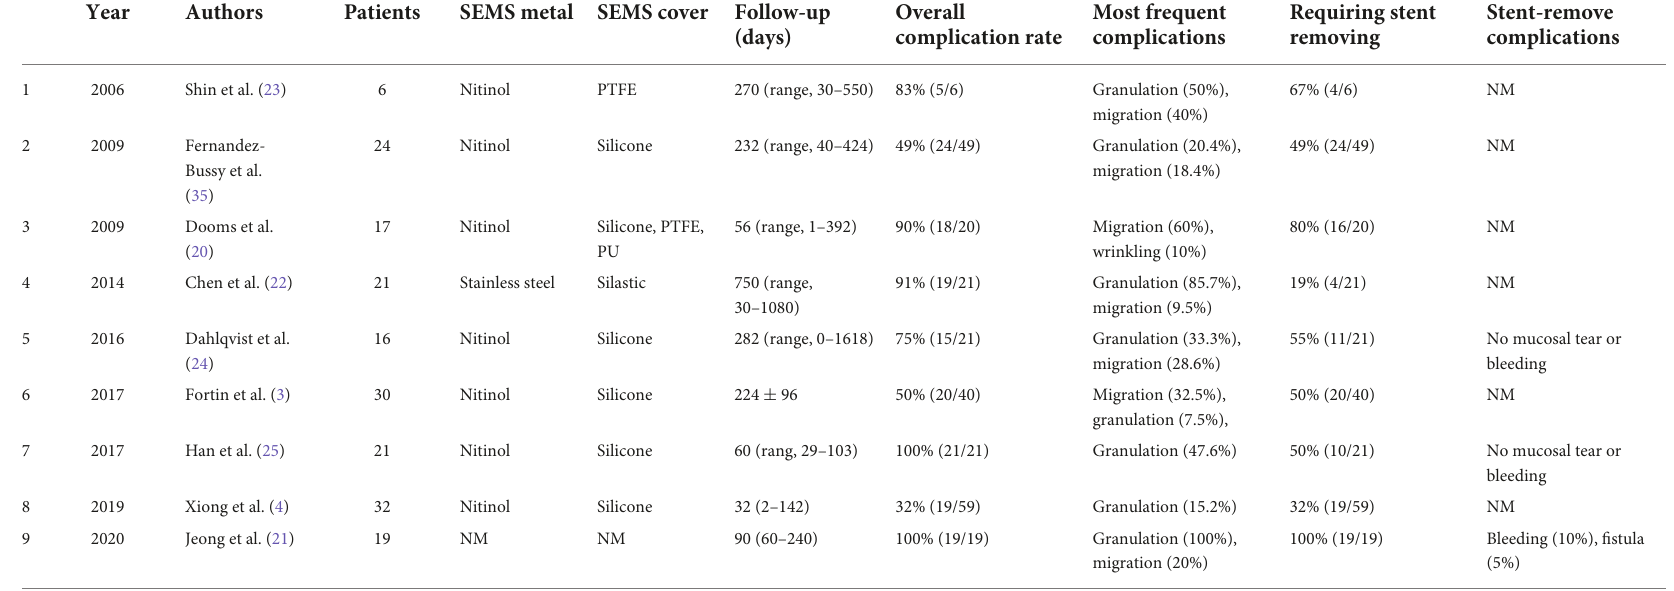
TABLE 1 Previously reported studies on fully covered SEMS in benign airway